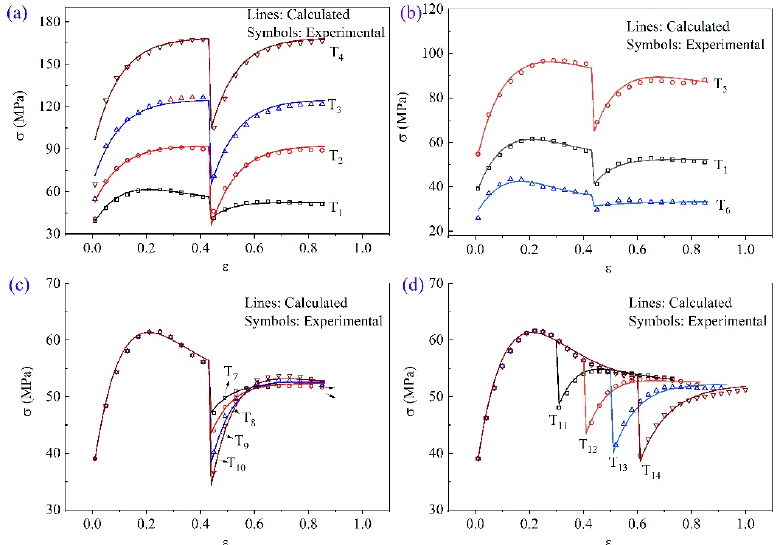
Figure 8. Comparison of the model predictions and experimental values for the double-pass compression. ( a ) T 1 –T 4 , ( b ) T 1 , T 5 , and T 6 , ( c ) T 7 –T 10 , ( d ) T 11 –T 14.